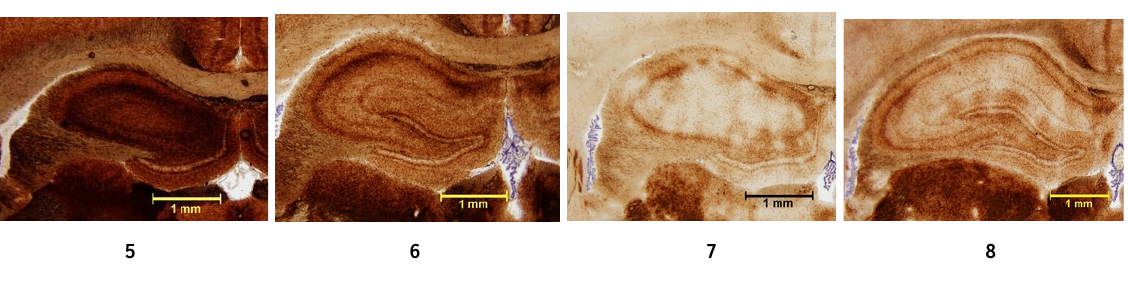
Figure 2. Top: Microphotography of 20 µ m sections of the rat brain (hippocampus) following huperzine, soman and huperzine followed by soman administration. 5 - control, 6 - Huperzine A, 7 – soman, 8 – Huperzine A + soman. Magnification: 40x, Staining: AChE [22].